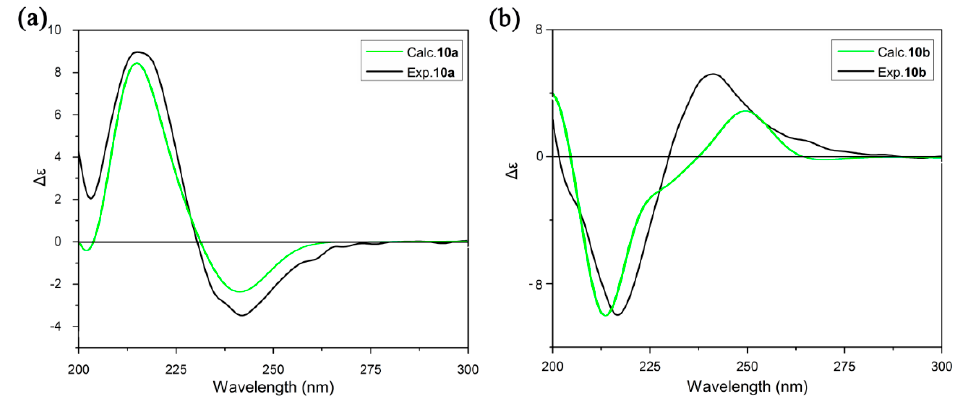
Figure 8. Experimental and calculated (TD-DFT/CAM-B3LYP/aug-cc-PVDZ) ECD spectra of ( a ) 10a and ( b ) 10b .